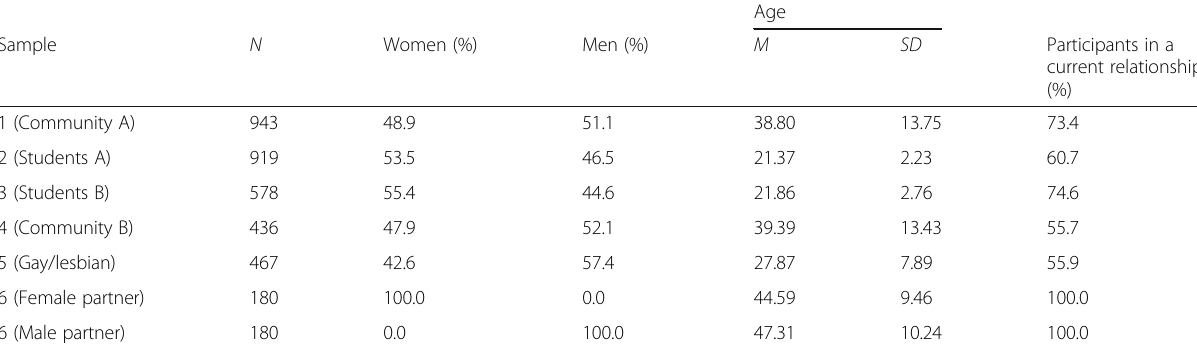
Table 1 Demographic features of the six